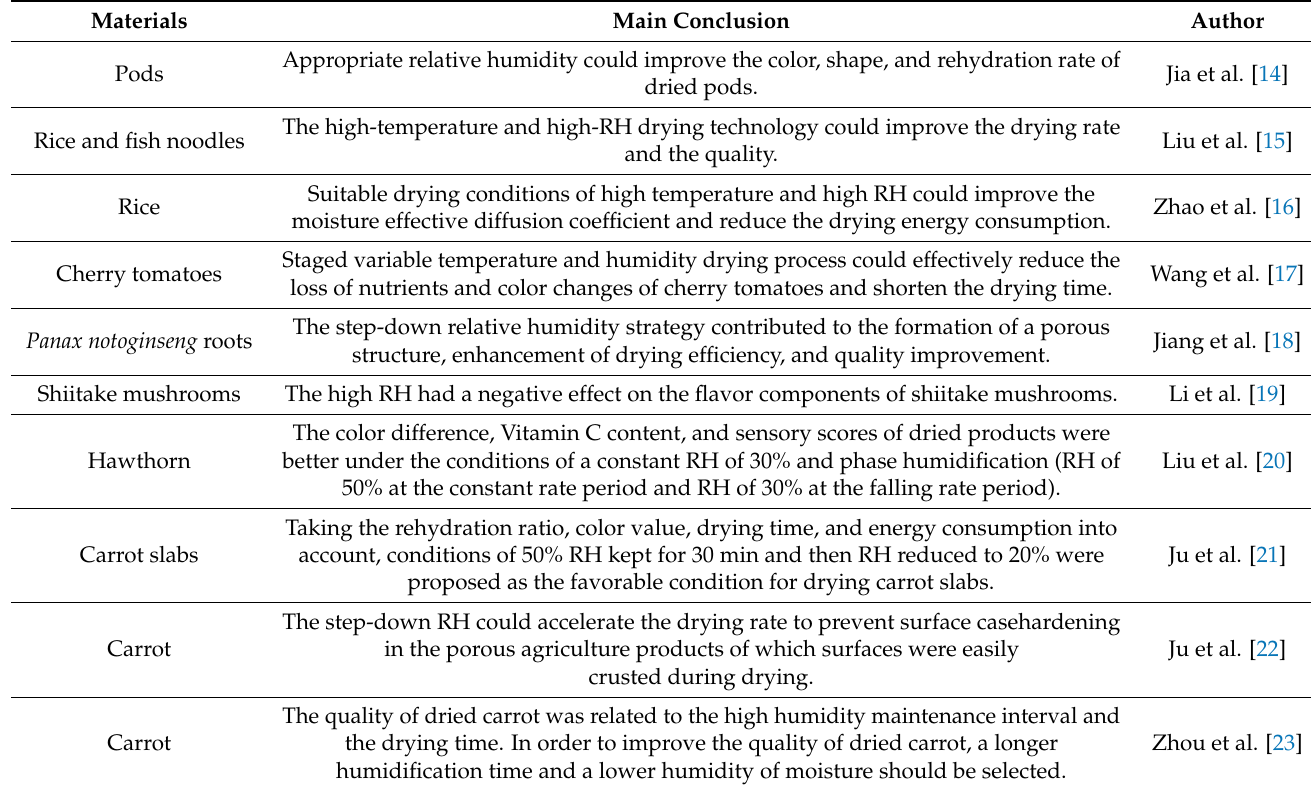
Table 1. Research status of the relative humidity (RH) in hot air